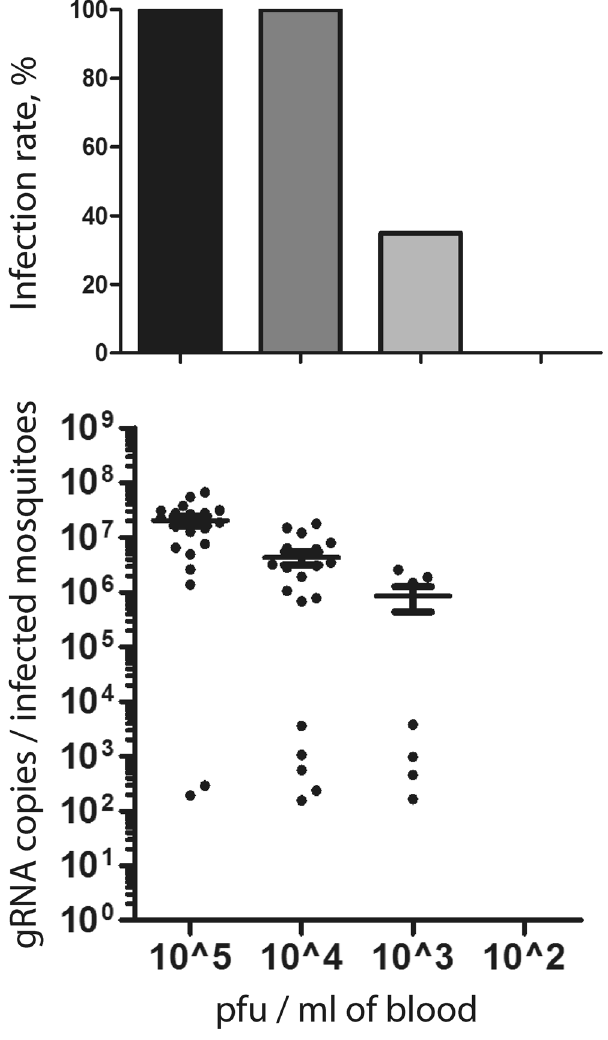
Figure 2. Zika virus can infect mosquitoes at a titer of 10 3 pfu/ml in the blood. Aedes aegypti mosquitoes were orally infected with 10 5 , 10 4 , 10 3 or 10 2 pfu of PF13 per ml of blood. At 7 days p.i., ZIKV genome copies were quantified in whole mosquitoes. Each point represents one mosquito sample. Twenty mosquitoes were tested per condition. Line shows average of gRNA